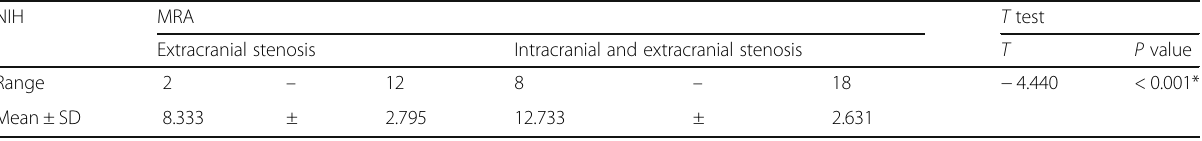
Table 3 Difference in NIHSS between the two groups NIH MRA